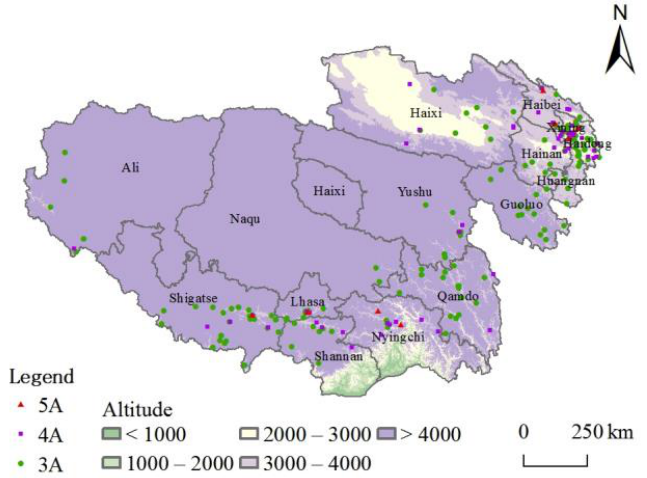
Figure 7. Spatial distribution of tourist attractions and altitude.